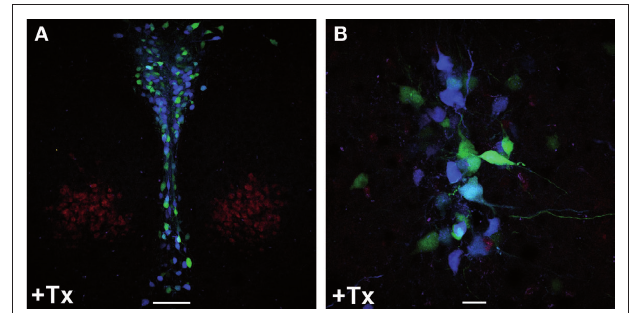
FIGURE 6 | Inducible glucocorticoid receptor (GR) knockout in serotonergic neurons of adult GRfl ox/GRfl ox TPH2-CreERT2 mice. Tamoxifen (1 mg twice daily) or vehicle was injected for fi ve consecutive days starting at P60. Coronal sections show dual-label fl uorescence immunohistochemistry for TPH and GR in vehicle-treated ( + Ve) (A–C) and tamoxifen-treated ( + Tx) GRfl ox/GRfl ox TPH2-CreERT2 mice (D–F) . Colocalization is visualized at the level of dorsal raphe nuclei using confocal images. (A,D) TPH fl uorescence; (B,E) GR fl uorescence; (C,F) merged images. (C) In vehicle-treated mice, GR colocalizes extensively with TPH. (F) GR is primarily expressed in TPH-negative neurons in tamoxifen-treated GR-knockout mice verifying the selective deletion of GR in 5-HT neurons. Scale bars: 100